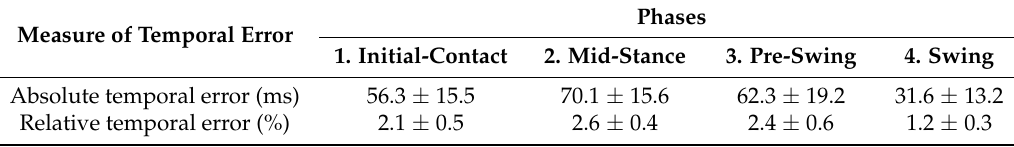
Table 1. Mean temporal error obtained for each of the four gait events across all subjects and all walking